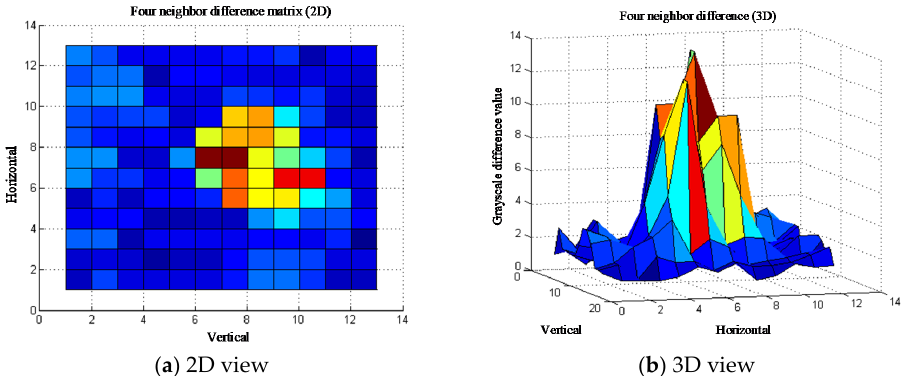
Figure 11. Results of the four neighbor block difference.